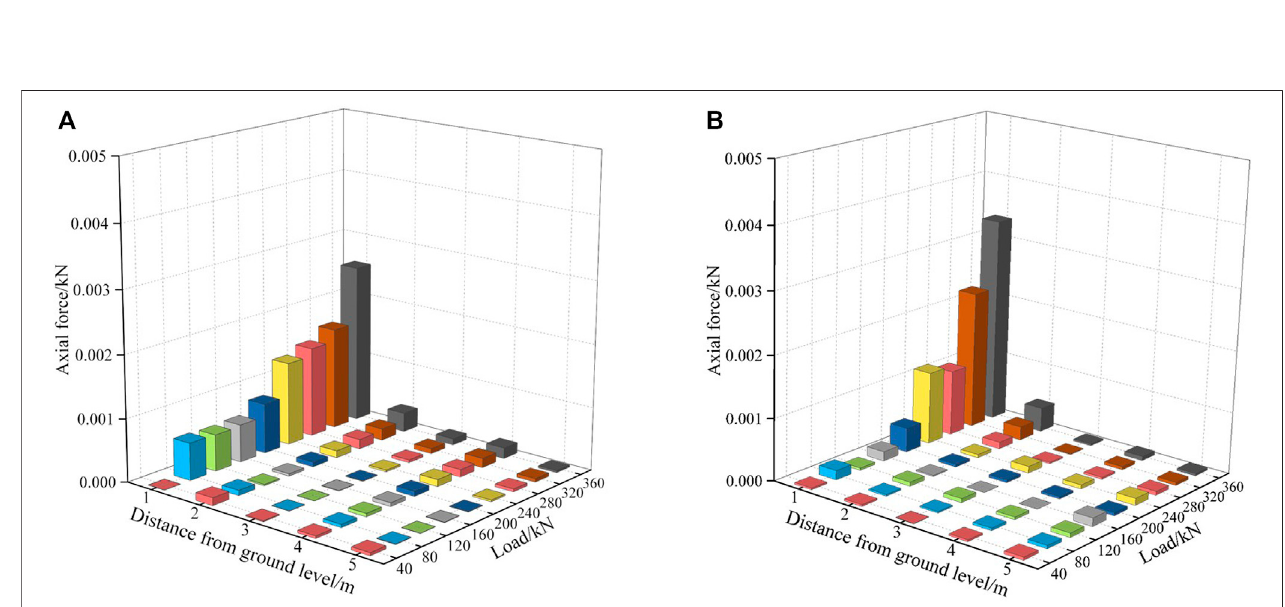
FIGURE 8 | Axial force change caused by the temperature change: (A) GFRP1 and (B) GFRP2.